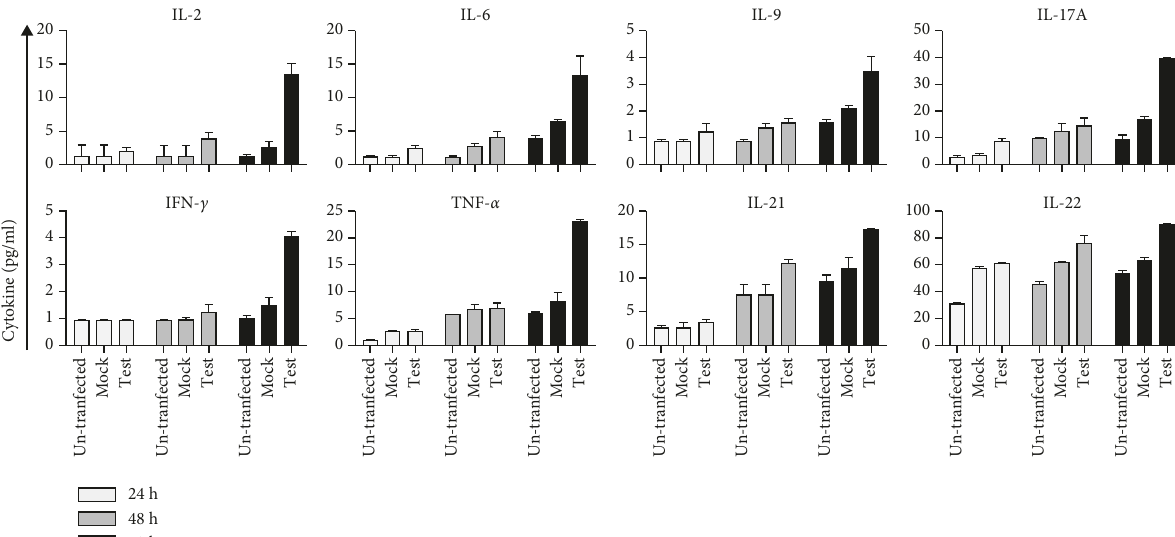
Figure 4: Increases in the levels of proinflammatory cytokines over time. No significant differences were found between the concentration of IL-2, IL-6, IL-9, and INF c in 24 to 48 hours after transfection in different test groups, whereas, the differences between the concentration of IL-17A and TNF- α among the groups was significant ( P < 0 .